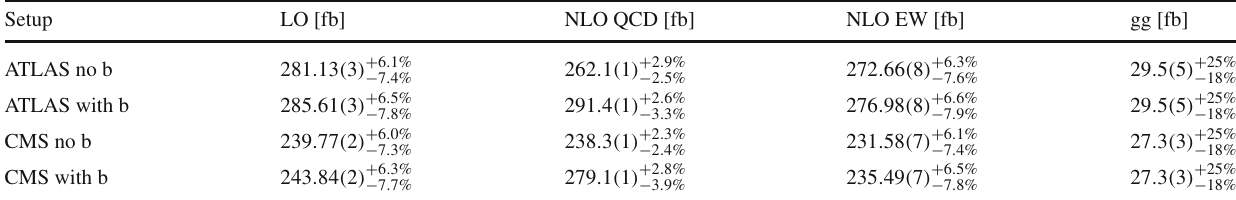
Table 1 Integrated cross section for the process pp → e + ν e μ − ¯ ν μ at √ s = 13TeV in the ATLAS and CMS setups of Eqs. (4.4) and (4.5), respectively. The numbers in parentheses correspond to the statistical